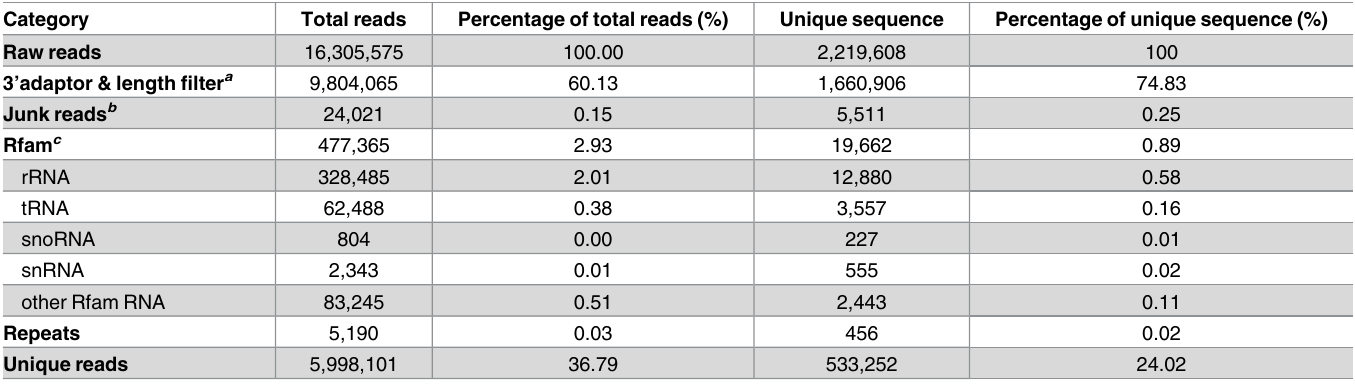
Table 1. Overview of sRNA sequencing